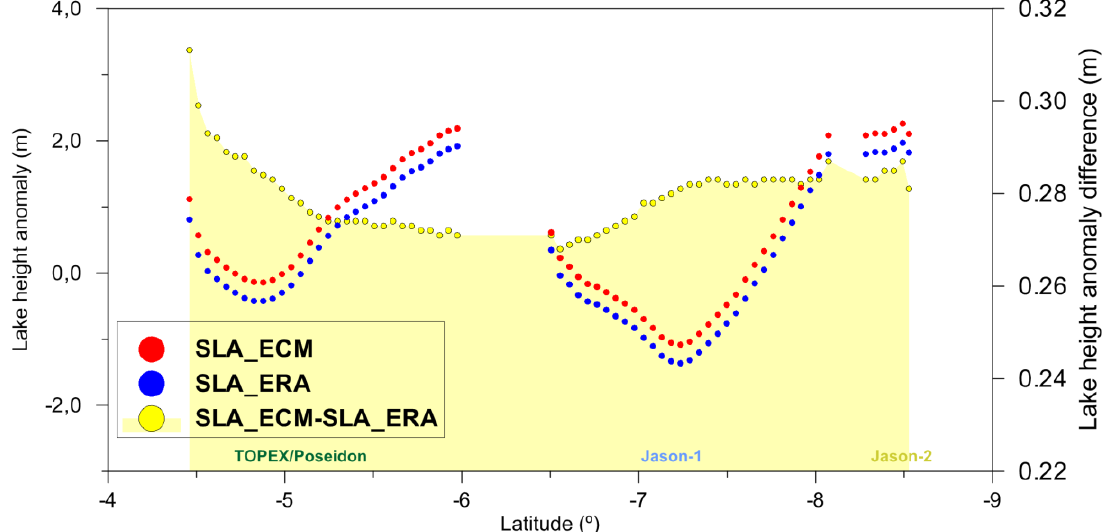
Figure 16. Mean water level anomalies (m) along T/P Pass 222 over Lake Tanganyika, derived using tropospheric (dry and wet) corrections from two models, for the whole period of T/P Phase A. Water level heights are with respect to the EGM2008 geoid. A mean lake height of 769 m has been removed. Results for NCEP are not shown, since they are very similar to those from ERA